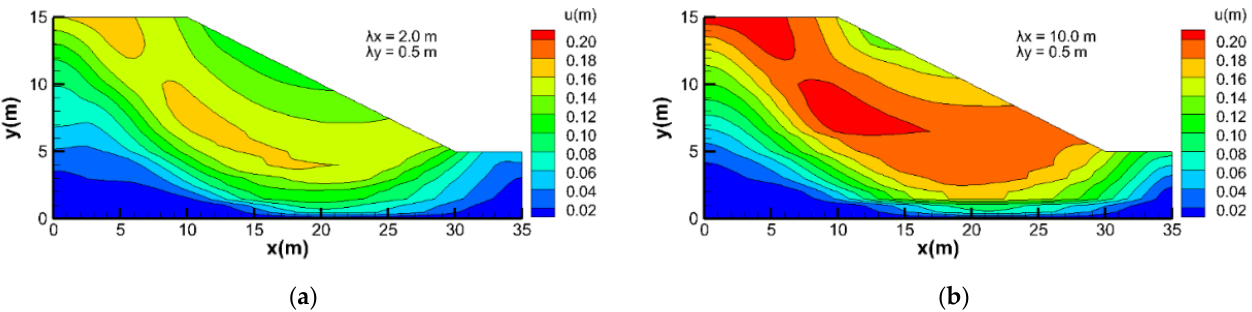
Figure 8. The contour map of the displacement of horizontal layered slopes with different λ x : ( a ) λ x = 2 m and ( b ) λ x = 10 m.